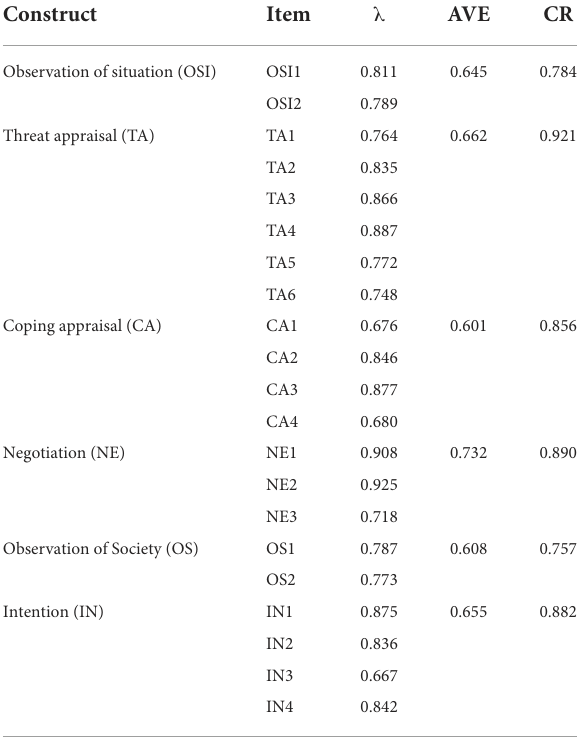
TABLE 5 Confirmatory factor analysis and scale reliability.